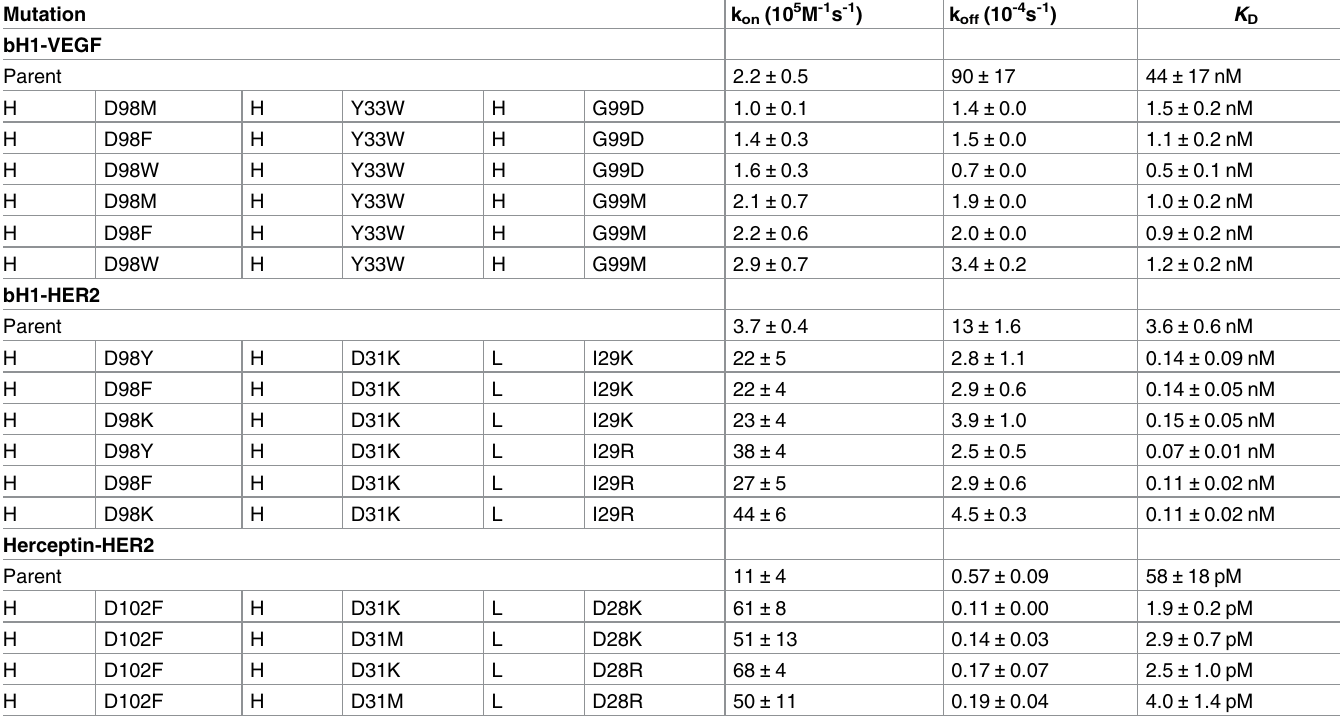
Table 1. SPR-measured k on and k off rates for the parent sequence and triple